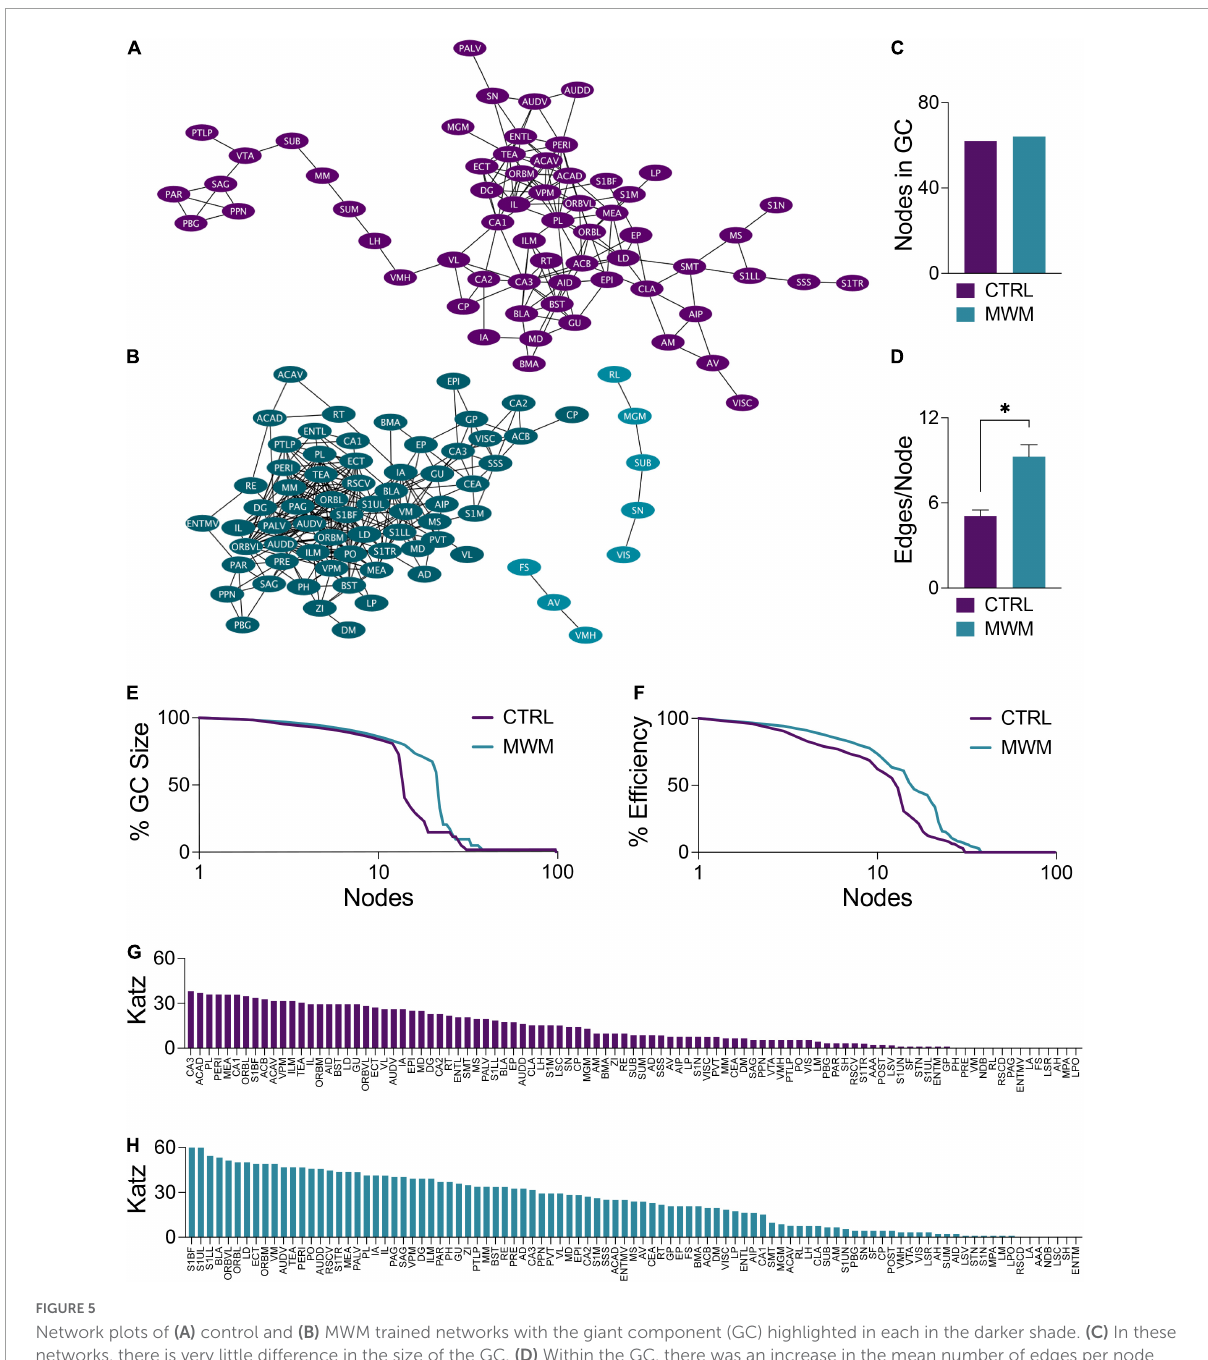
FIGURE5 Network plots of (A) control and (B) MWM trained networks with the giant component (GC) highlighted in each in the darker shade. (C) In these networks, there is very little difference in the size of the GC. (D) Within the GC, there was an increase in the mean number of edges per node with MWM training (Two-tailed t test, p < 0.0001). MWM training also made the (E) integrity of the GC and the (F) global efficiency of the network more resilient to targeted node deletion. Relative to the control condition (G) , MWM training (H) also increased Katz centrality of a subset of regions within the network. Data shown are mean ± SEM when